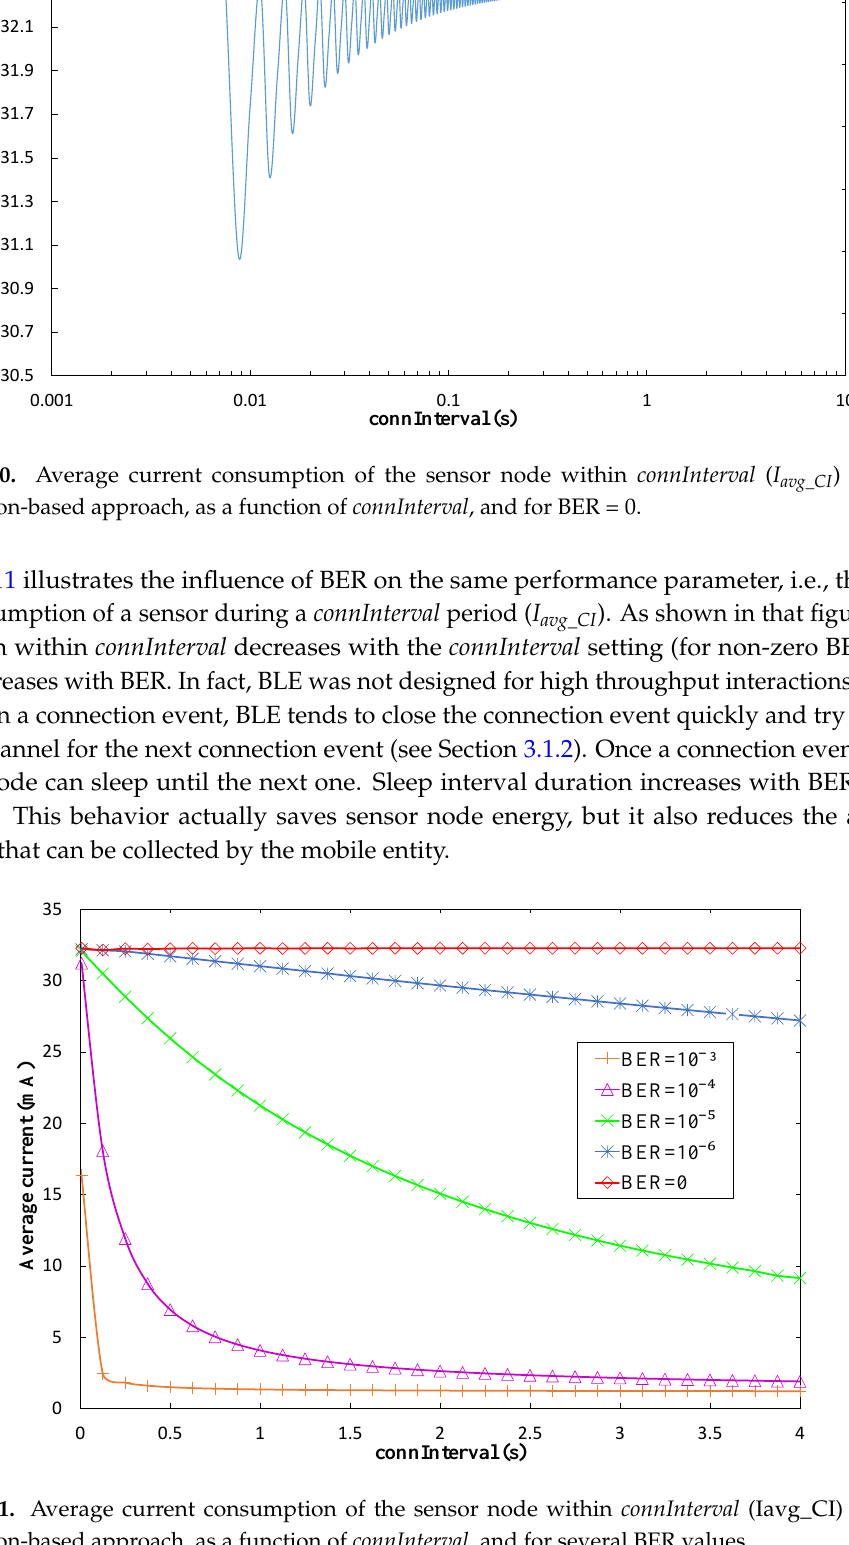
15 of 29 Figure 9. Average current consumption of the sensor node in the advertisement-based approach, as a function of advInterval , and for both N = 1 and N = 3. 5.1.2. Connection-Based Approach For the analysis of the connection based-approach, we first study the sensor node average current consumption within a period of connInterval (once a connection has been established), we then evaluate the average current consumption during T conn , and finally we obtain the average current consumption of the connection-based approach. Figure 10 depicts the average current consumption of a sensor during a connInterval period ( I avg_CI ), as a function of connInterval , by using the values in Tables 1 and 2, and Equation (16). The